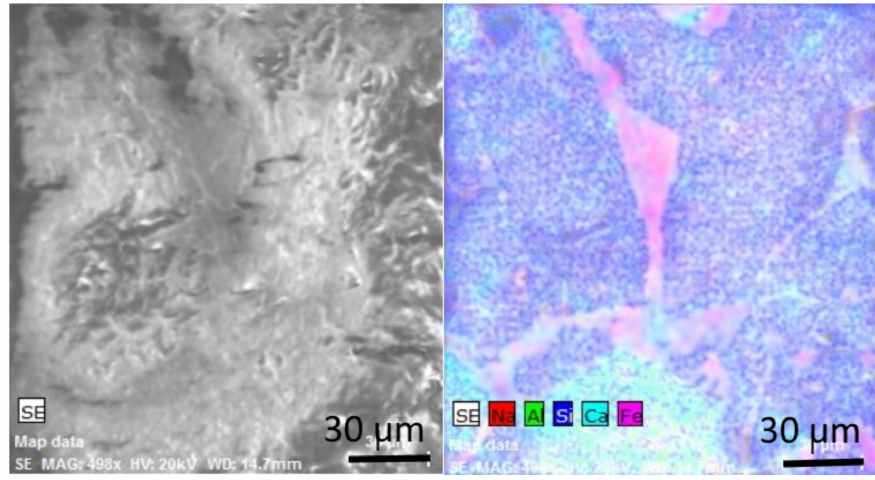
Figure 15. Backscattered electron image and associated EDX map obtained for some indicated elements.